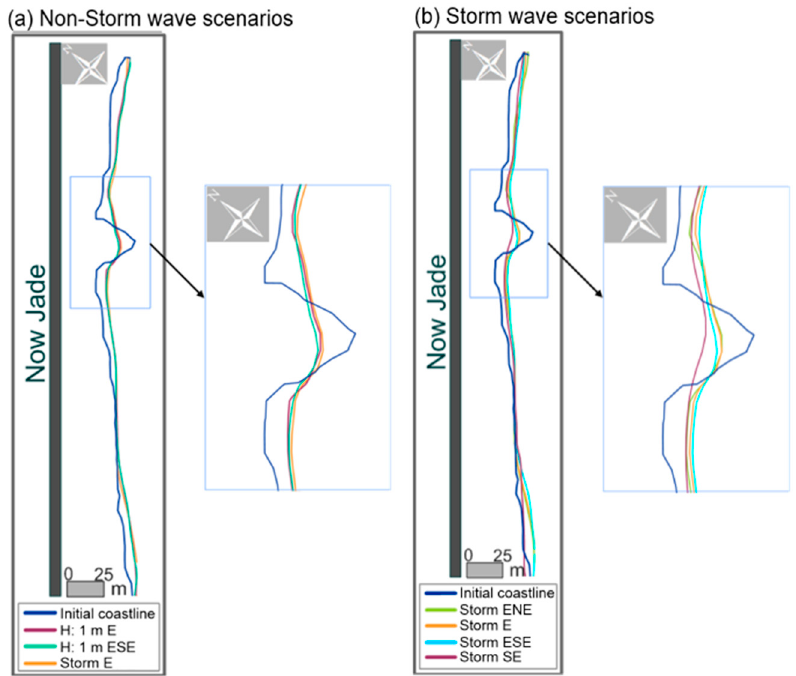
Figure 13. Coastline changes for the simulated scenarios (t: 30 h): ( a ) non-storm wave conditions; ( b ) storm scenarios.